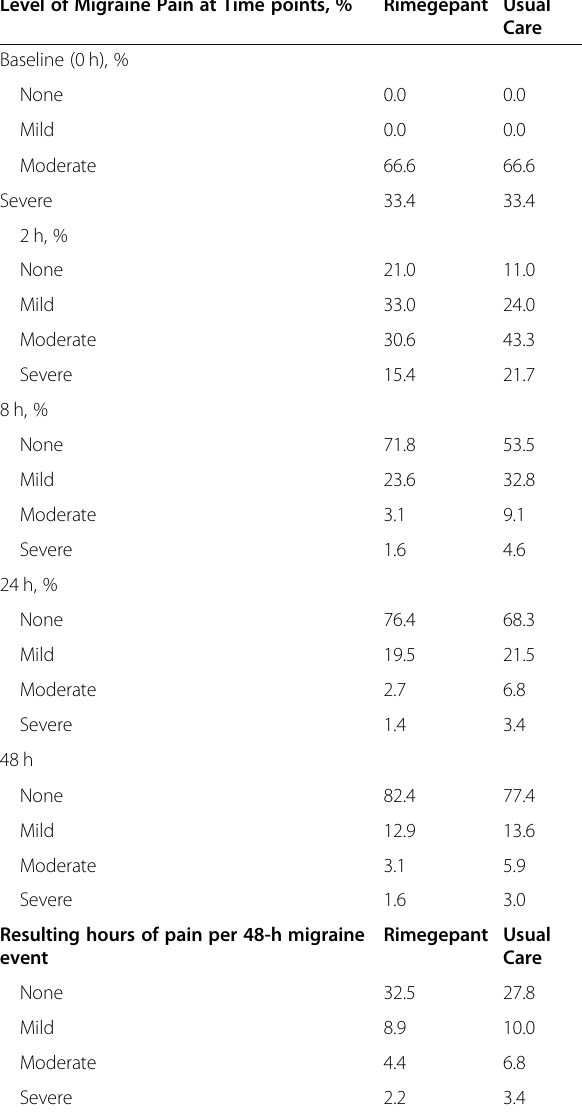
Table 2 Treatment Response in Base-Case ICER Model Level of Migraine Pain at Time points, % Rimegepant Usual